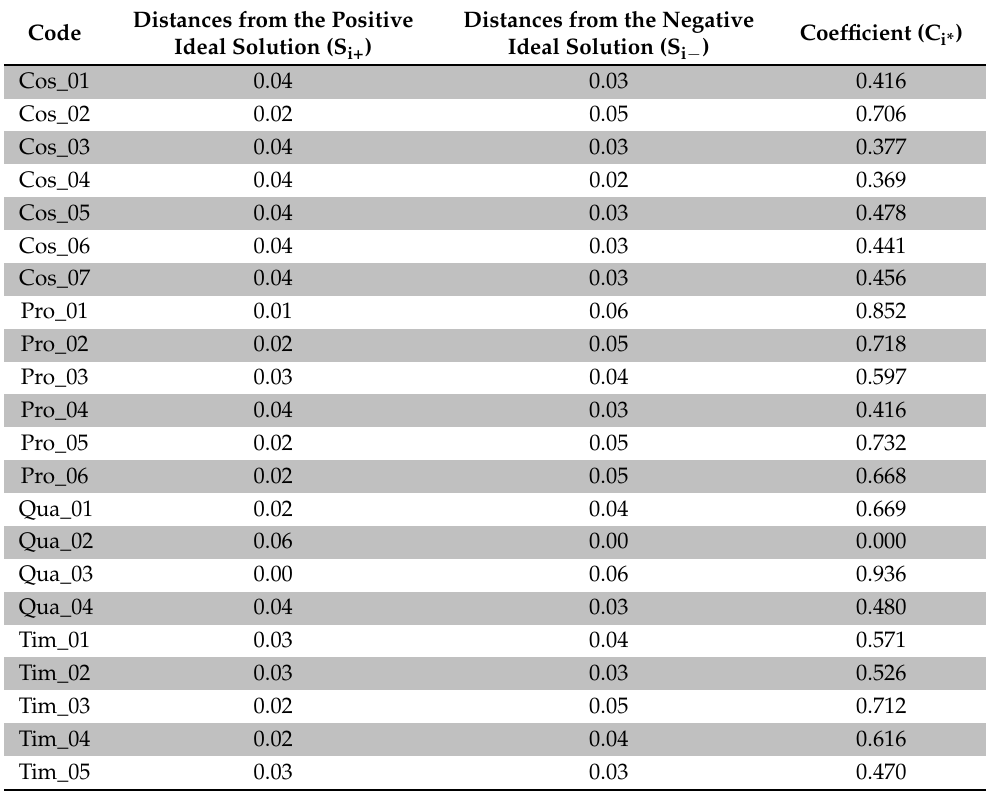
Table 6. Distances from the positive ideal solution, distance from the negative ideal solution and C i* coefficient. Source: authors.